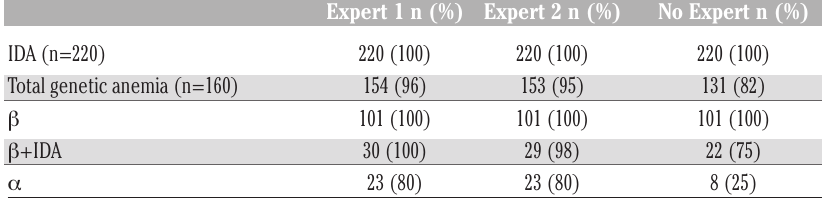
Table 2. Three professionals, two experts in laboratory medicine and a trainee, reviewed the cytograms, with no information regarding the disease of the patient. The diagnosis of each patient was retrieved from his or her laboratory and medical records. The observers made a presumptive diagnosis (genetic or acquired anemia) and the percentages of correct classification recorded as